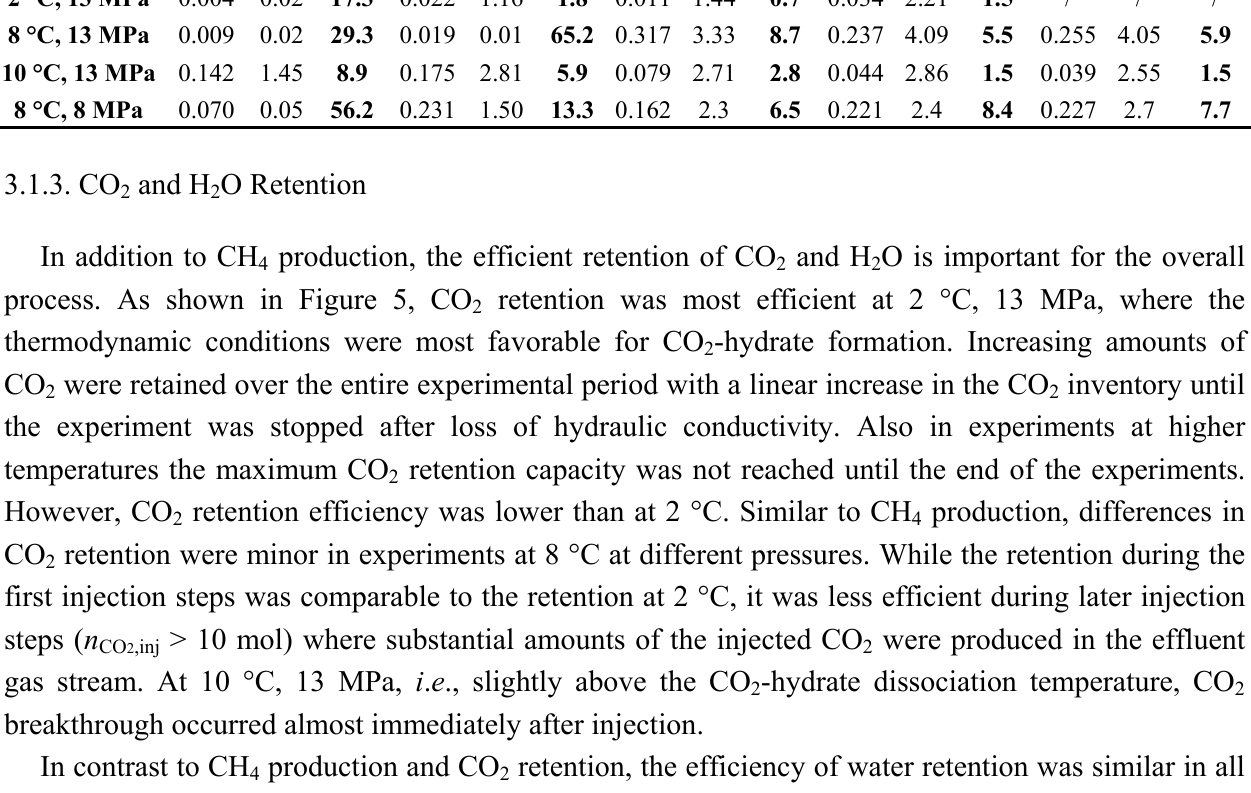
and CO recovered in 4 2